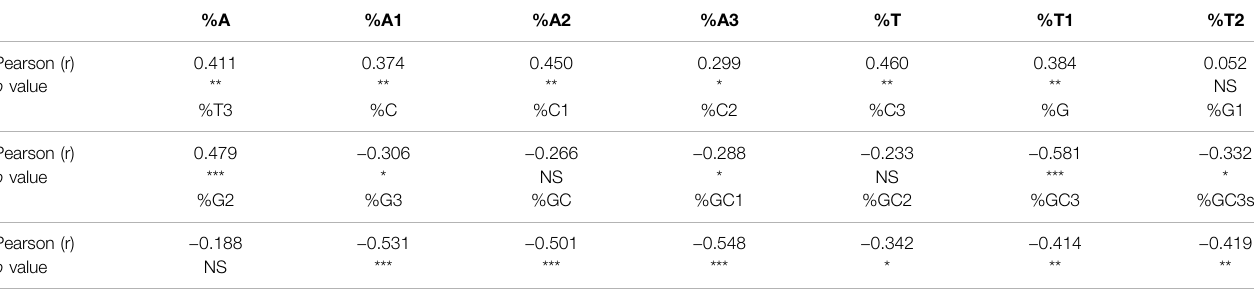
TABLE 2 | Correlation between nucleotide compositions and